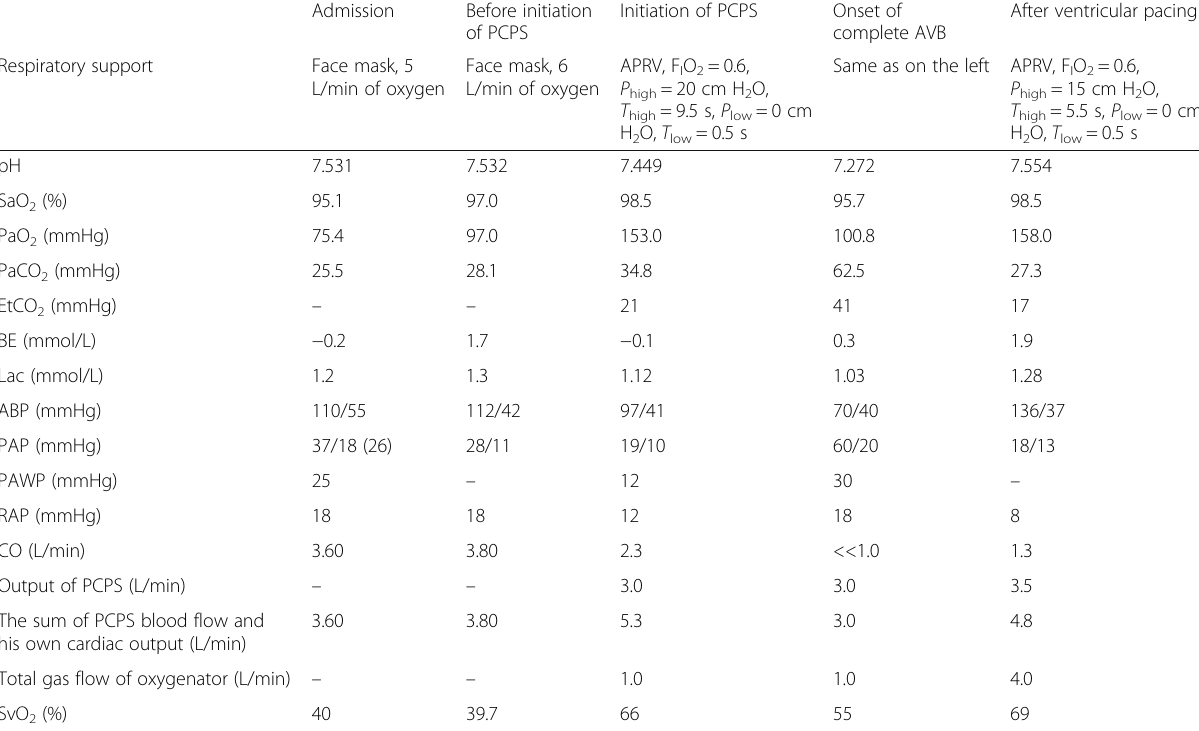
Table 2 Hemodynamic status of the patient on admission, before and after the initiation of PCPS, after the onset of complete atrioventricular block, and after ventricular